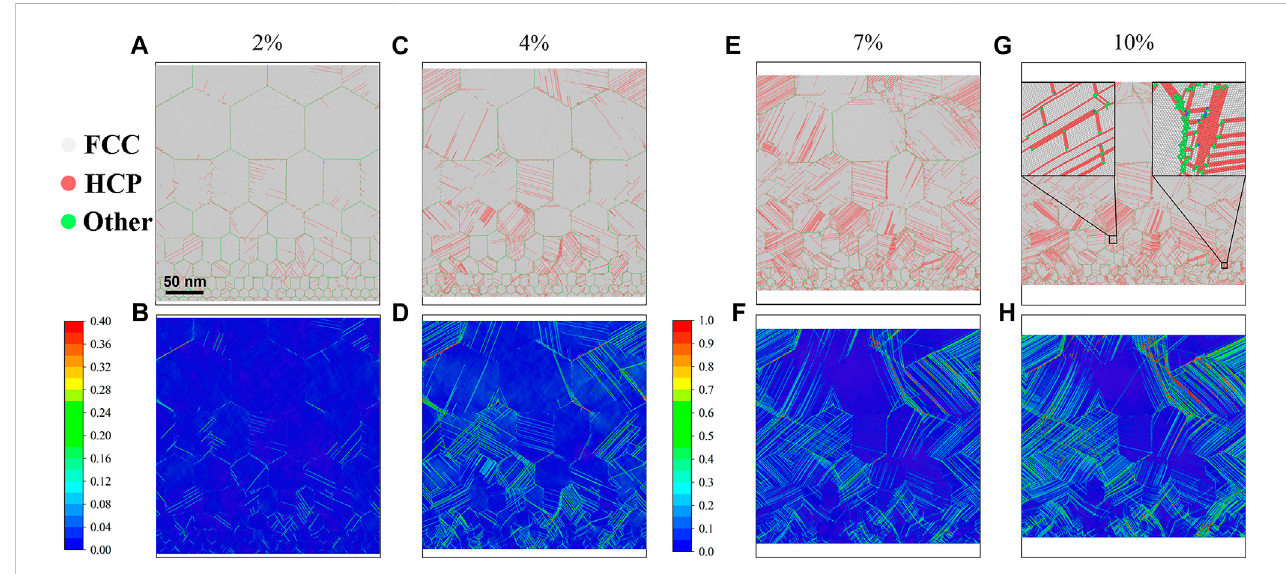
FIGURE 3 Snapshots from GNG structured model of atomistic structure and atomic tensile strain at applied tensile strain of (A,B) 2%, (C,D) 4%, (E,F) 7% and (G,H) 10%.